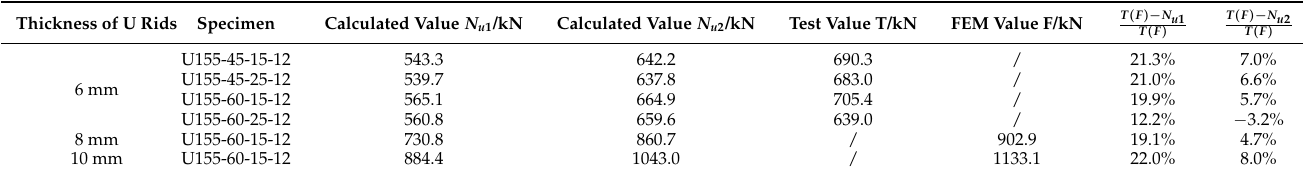
Table 4. Ultimate bearing capacity of steel–UHPC composite